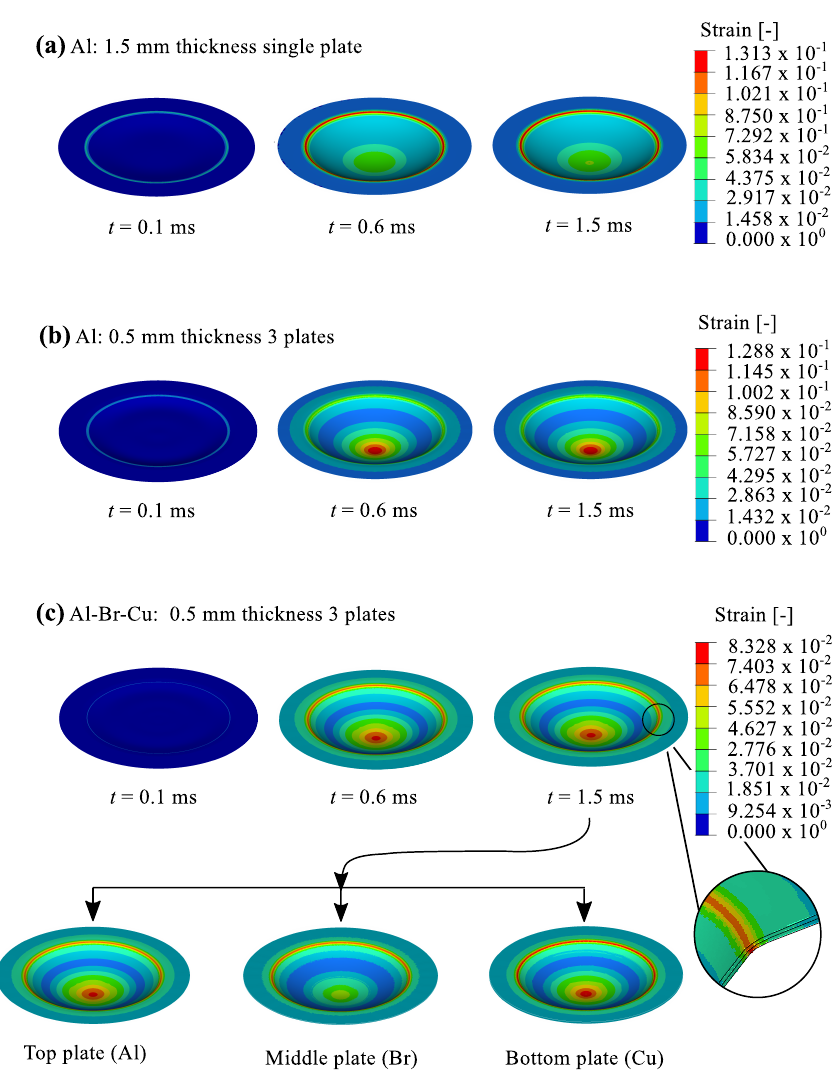
Figure 14. Effective strain distribution of ( a ) a single metal sheet of Al, ( b ) three stacked sheets of Al and ( c ) combination of Al-Br-Cu in numerical